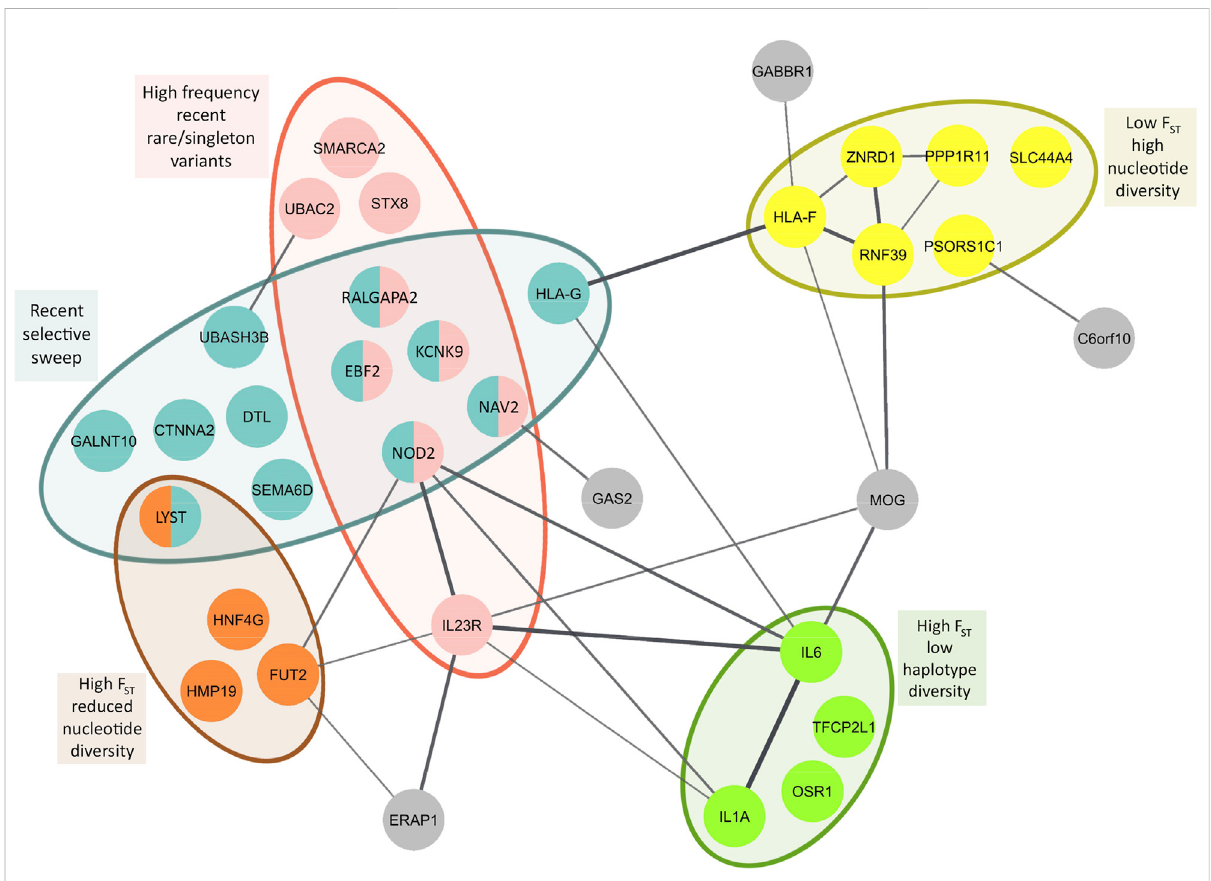
FIGURE 4 Population genetic parameter and selection estimates superposed on to protein-protein interaction network of BD associated genes with population genetic parameter and selection estimates unique to East Asians. Primary interactions based on functional and physical protein associationsonlyfromcurateddatabasesandexperimentallydeterminedsourcesarepresented.Linethicknessoftheedgesindicatesthestrengthof data support. High and low F st represent population differentiation of East Asians with respect to